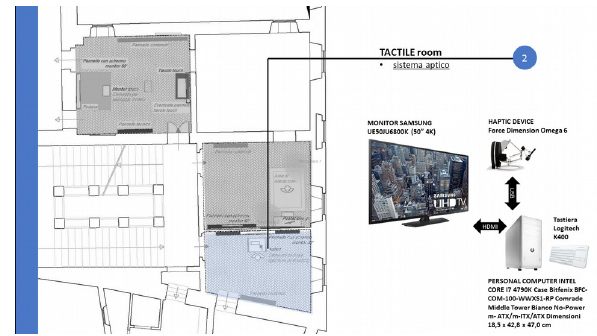
Figure 8. Devices and positioning of TACTILE room.